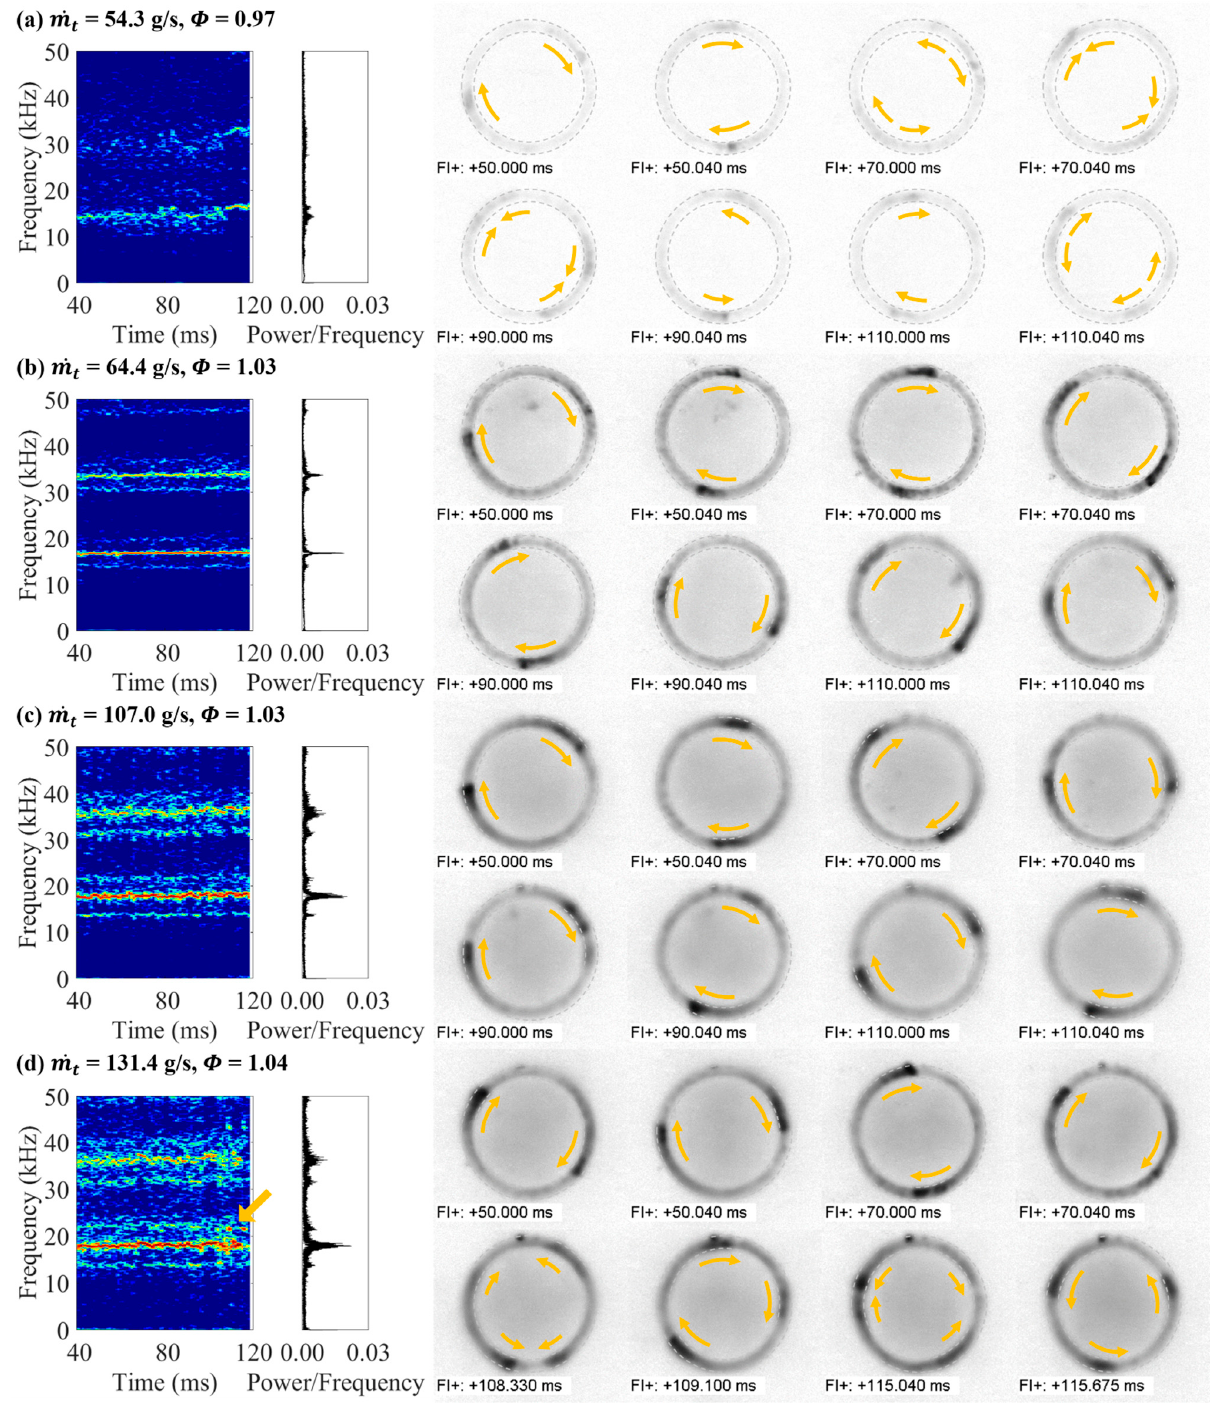
Figure 8. Comparison of the detonation behaviors under different conditions through fast Fourier transform (FFT), short- time Fourier transform (STFT), and a snapshot captured at a 256 × 256 resolution and 200 kfps: ( a ) unstable waves; ( b ) two stable waves; ( c ) two stable waves; ( d ) two stable waves and three temporally stable waves.